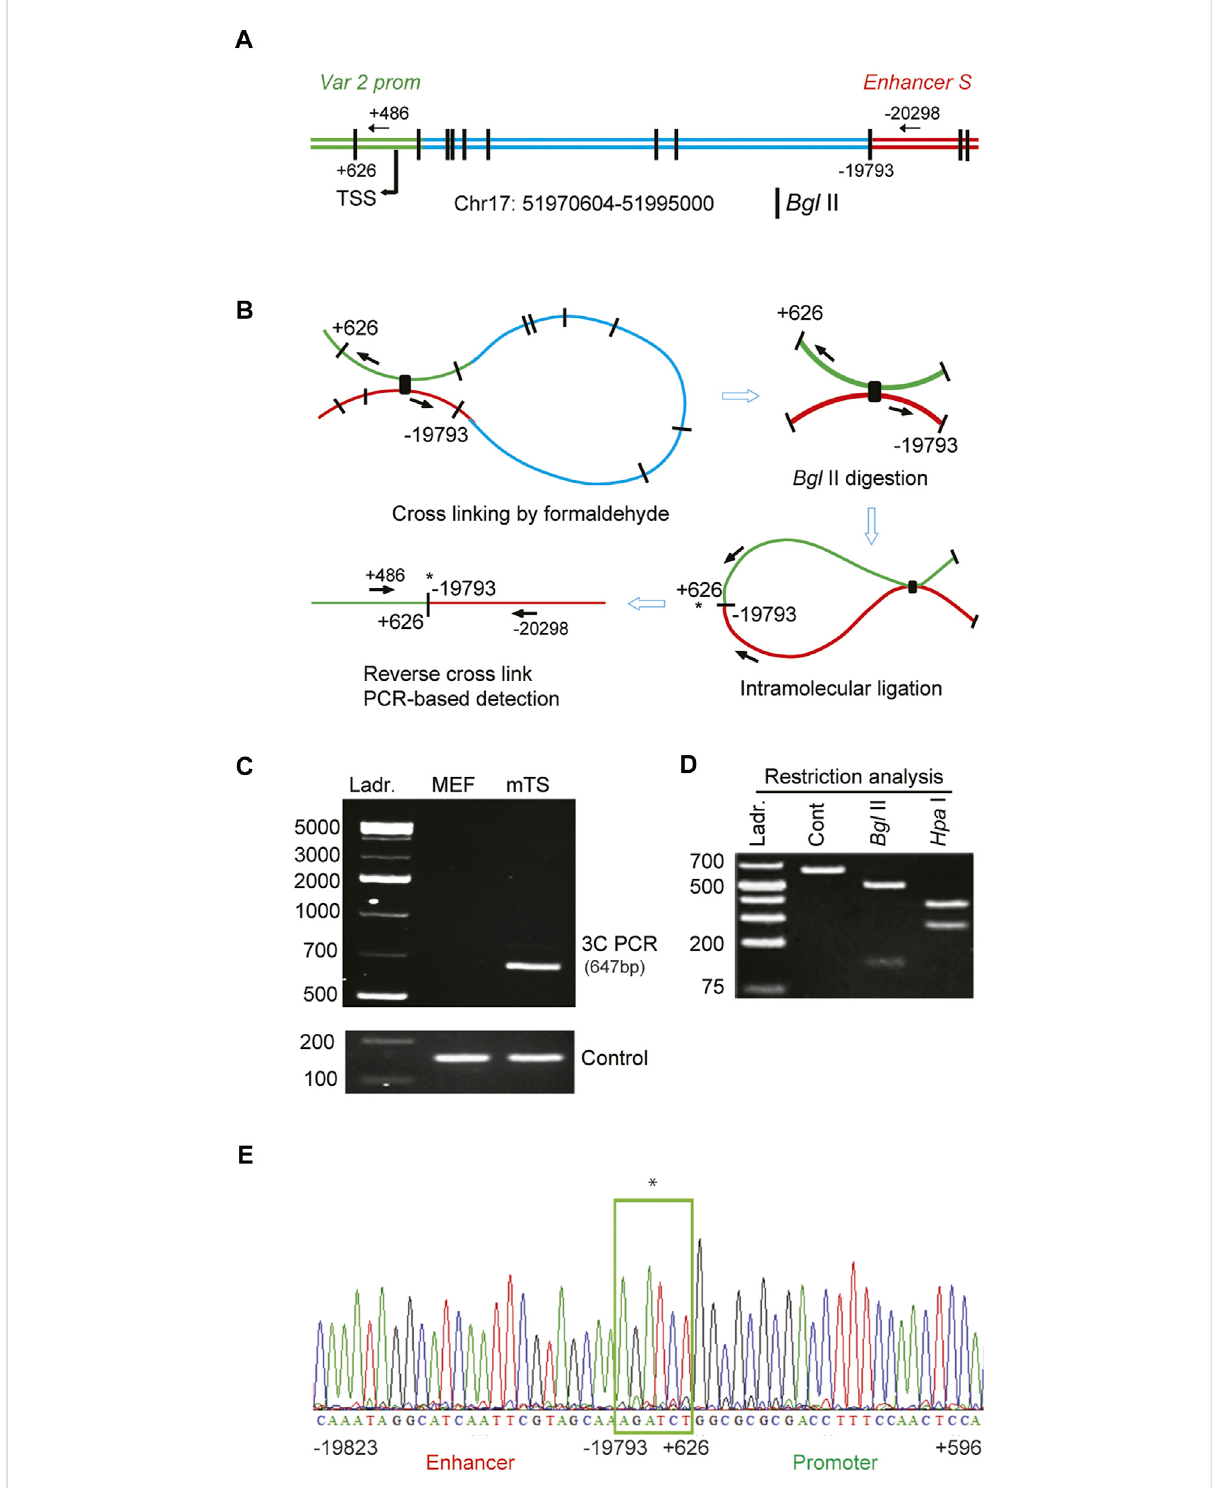
FIGURE 5 Enhancer S loops into the Satb1 promoter in mouse TS cells. (A) Schematic diagram of the mouse Satb1 locus showing the variant 2 promoter (var2 prom), transcriptionstart site(TSS), Bgl II restrictionsites, and 3CPCR primer positions. (B) Representationof themajor steps of3C PCR-based detection of the looping and interaction of enhancer S with the Satb1 var 2 promoter. 3C PCR detected a physical interaction of the enhancer with the Satb1 promoterinmouseTS(mTS)cellsbutnotinmouseembryonic fi broblast (MEF)cells (C) .The3CPCRproduct(648 bp)wascon fi rmed by restriction analyses (D) as well as DNA sequencing (E) . *indicates DNA ligation site. Ladr., DNA